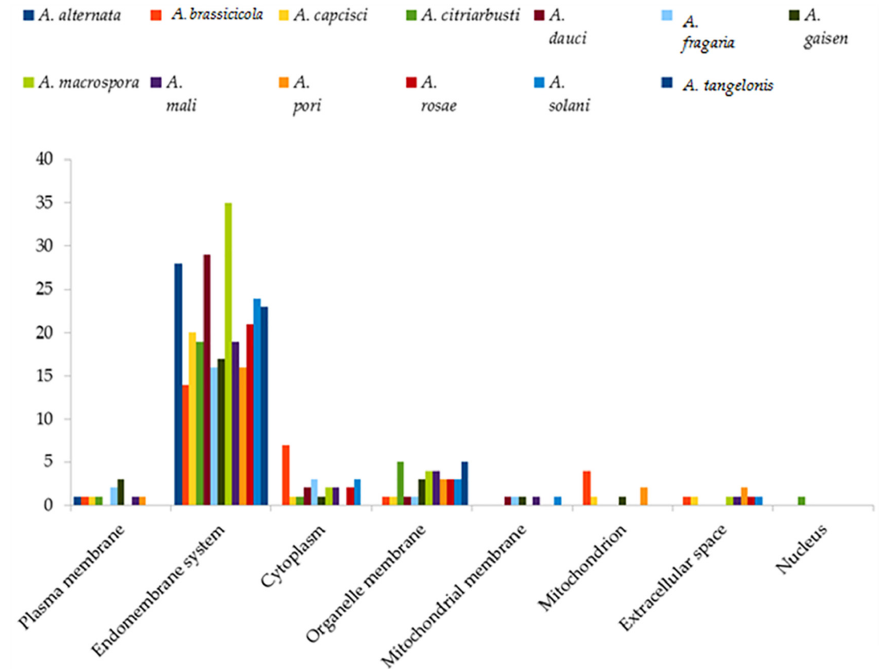
Figure 3. Subcellular localization of cytochrome P450 proteins in thirteen Alternaria species.